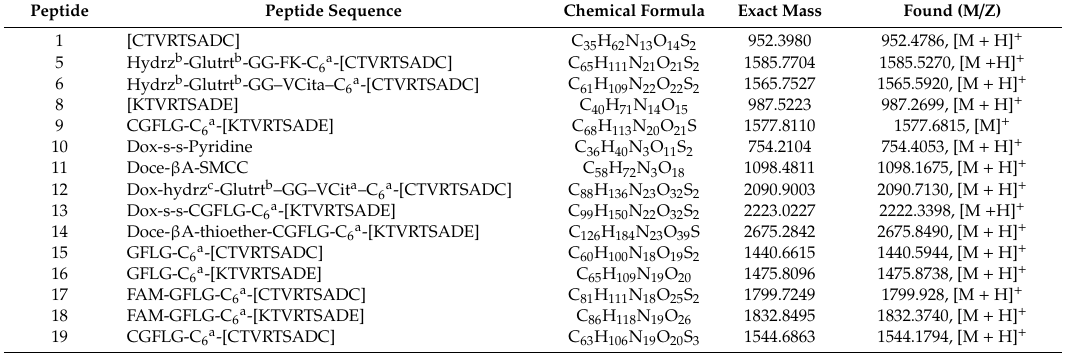
Table 1. The sequences of extra domain B of fibronectin (EDB-FN) targeting peptides and peptide–drug conjugates. Peptide Peptide